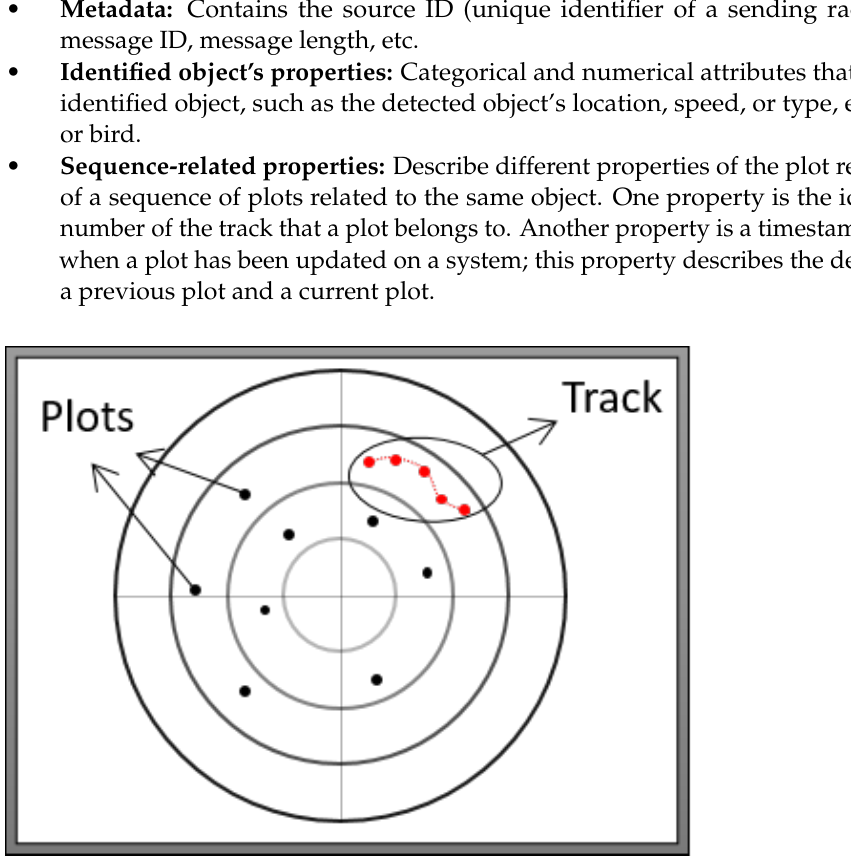
Figure 2. Objects identified at a specific timestamp are represented by points. A sequence of points related to the same detected object are represented by a path of interconnected points, i.e., a